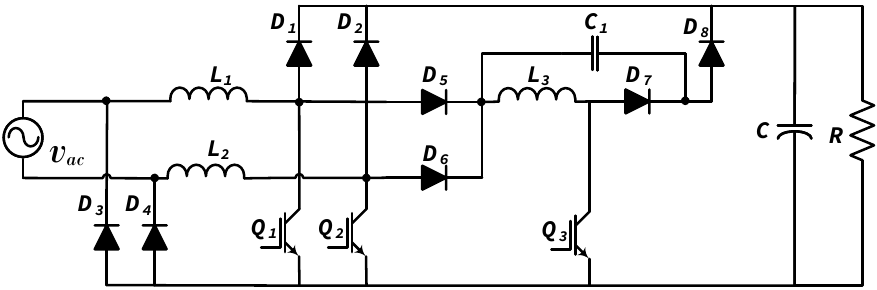
Figure 14. Semi-bridgeless topology with an internal snubber circuit.